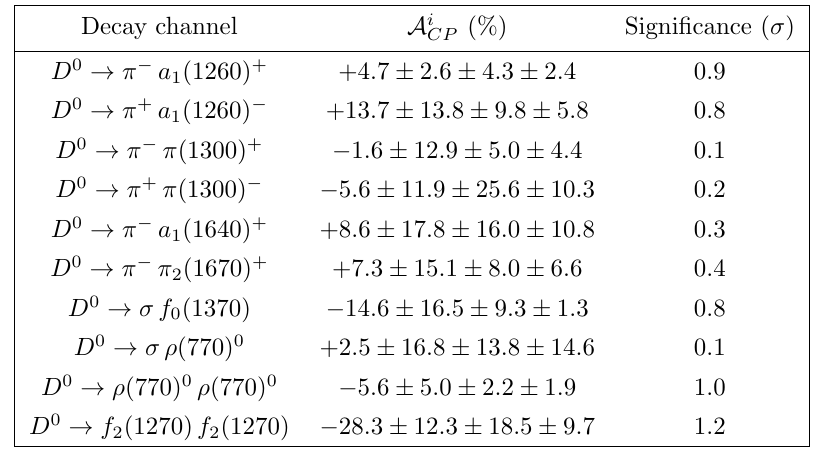
Table 6 . Direct CP asymmetry and signi(cid:12)cance for each component of the D 0 ! (cid:25) + (cid:25) (cid:0) (cid:25) + (cid:25) (cid:0) LASSO model. The (cid:12)rst uncertainty is statistical, the second systematic and the third due to alternative